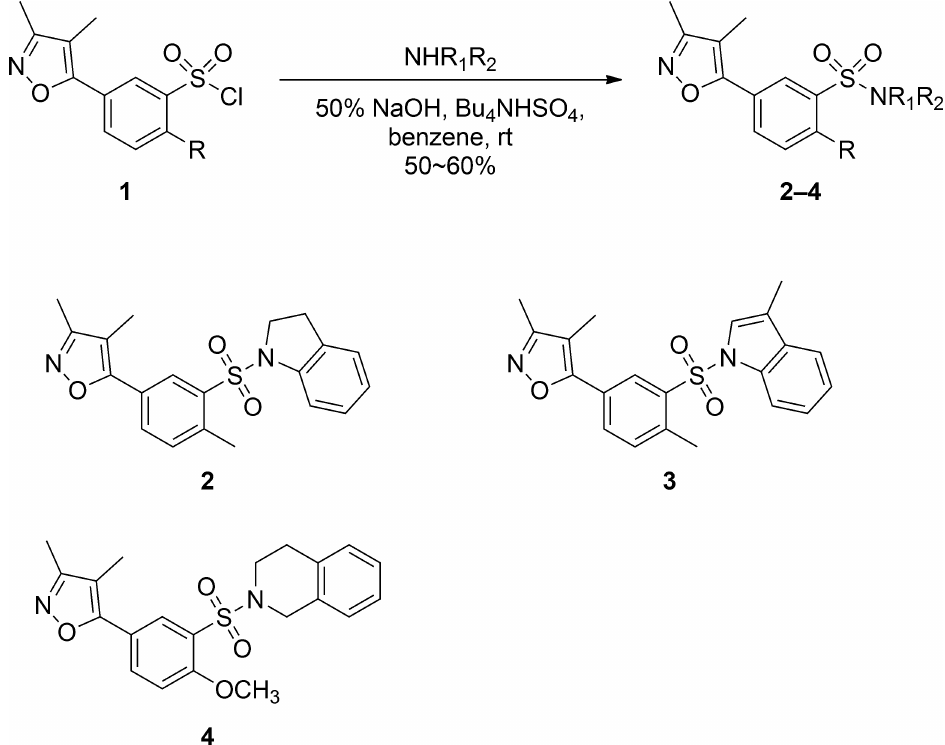
Fig 1. Synthesis of aminosulfonylarylisoxazole derivatives. Compounds 2–3 were preparedvia the couplingreaction of sulfonyl chloride 1 and the correspondingamine.